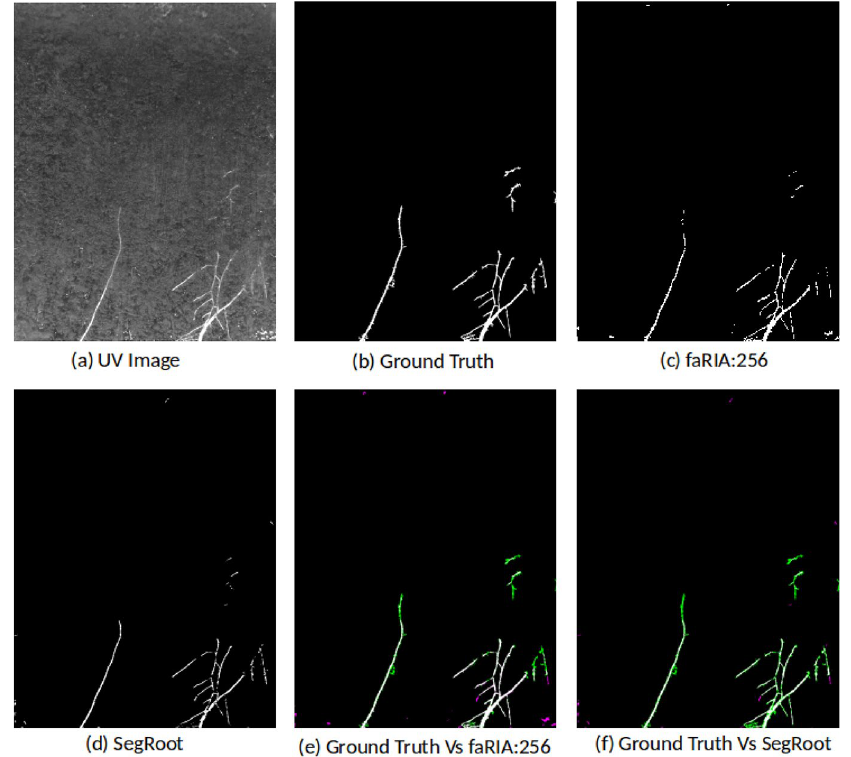
Figure 10. Applicability of faRIA on UV soil-root images: ( a ) image of arabidopsis plant roots from UV imaging system, ( b ) ground truth segmentation generated by saRIA, ( c ) predicted segmentation using faRIA:256, ( d ) predicted segmentation using SegRoot, ( e ) overlay of faRIA prediction on ground truth with DC = 0.80, ( f ) overlay of SegRoot prediction on ground truth with DC = 0.67. Green, pink and white colour pixels represents false negatives, false positives and correctly segmented pixels in the predicted image with respect to ground truth